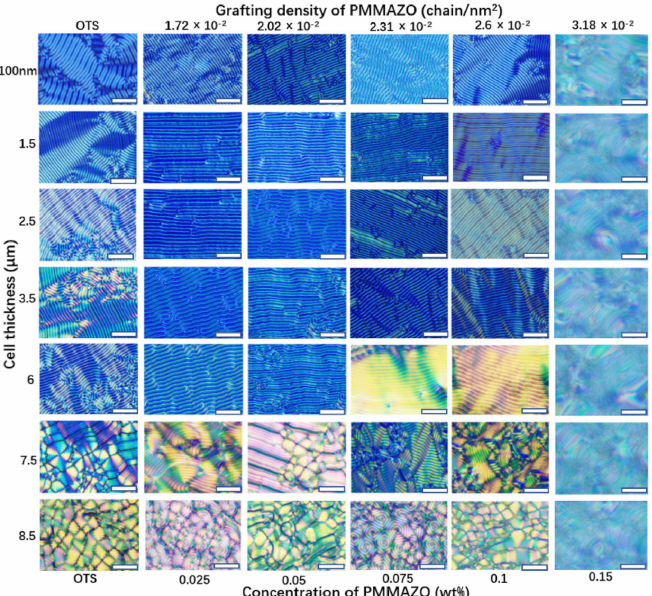
Figure 2. Morphologies of CLCs confined in cells of different cell thicknesses and grafting densities of PMMAZO. The scale bar is 25 µ